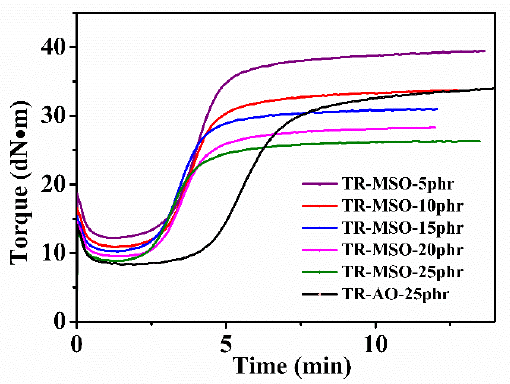
Figure 6. Vulcanization characteristics curve of tread rubber with different amounts of plasticizer.